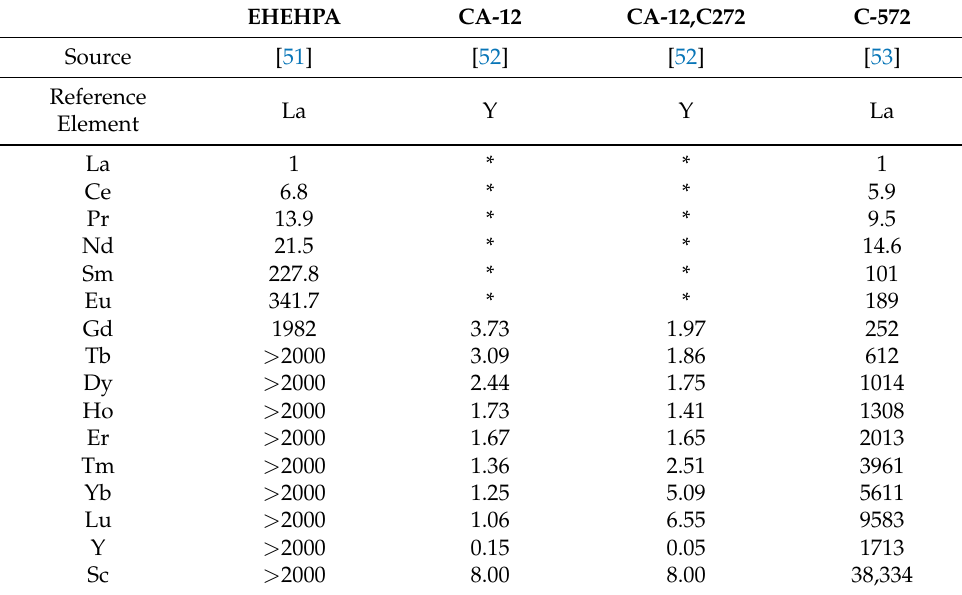
Table 1. Model separation factors. (“*” denotes factors not reported).